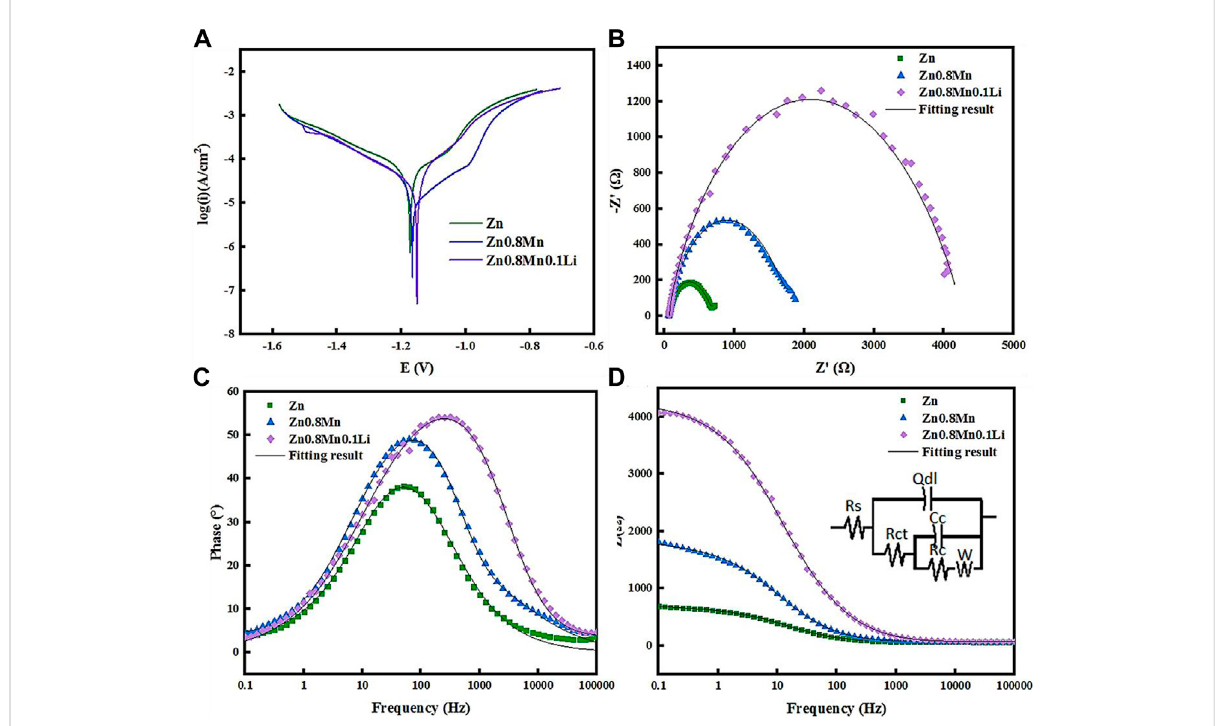
FIGURE 4 Polarization curves and EIS results of pure Zn and Zn-based alloys in SBF. (A) Potentiodynamic polarization curves. (B) Nyquist plots. (C) Bode plots of phase angle vs. Frequency. (D) Bode plots of |Z| vs. Frequency. The inset in Figure 4D is an equivalent circuit for fi tting the EIS spectra.